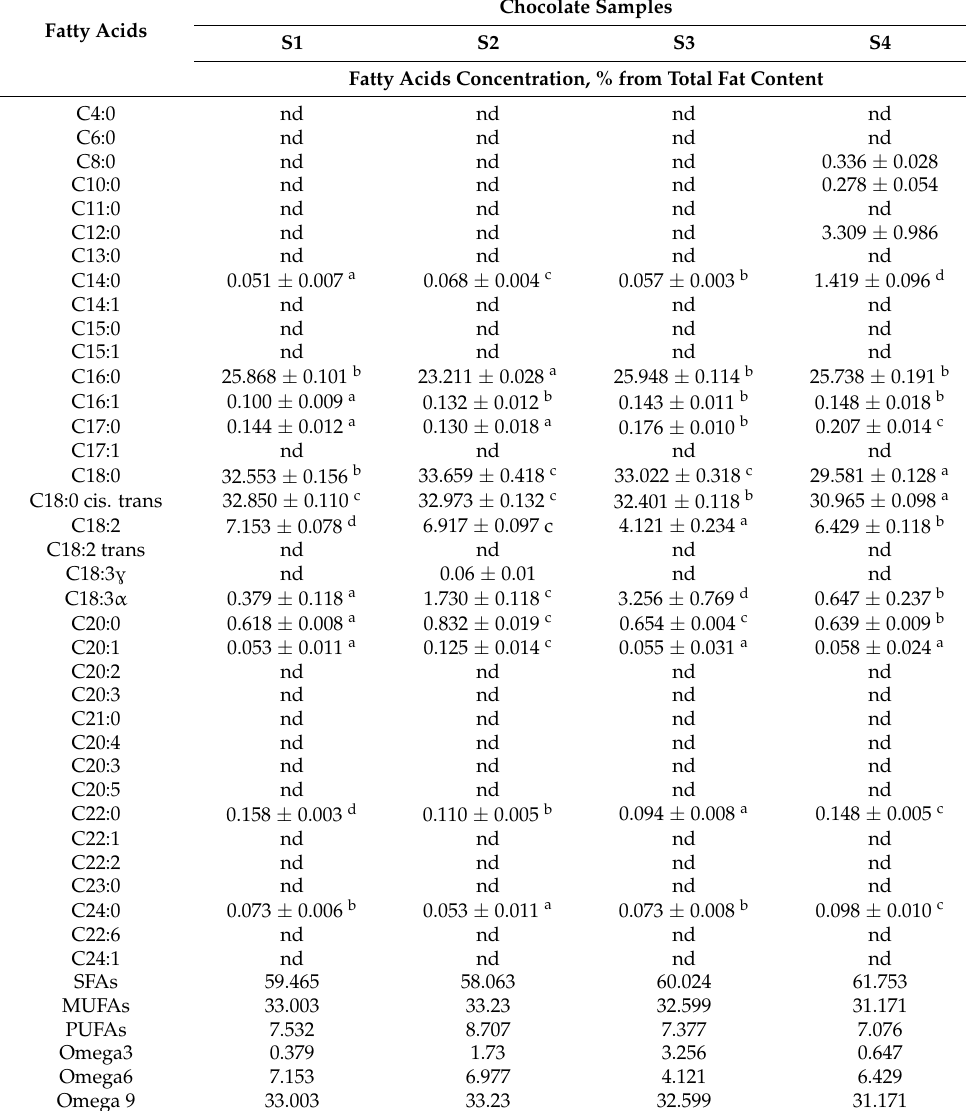
Table 2. Fatty acid profile of the dark chocolate.